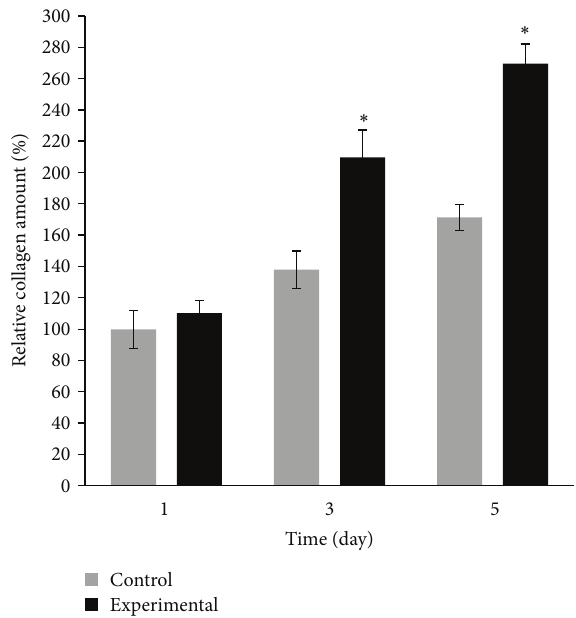
Figure 8: Relative amount of collagen within the PU scaffold during cell cultivation. Values were normalized ( 𝑛 = 5 , ∗ 𝑃 < 0.05